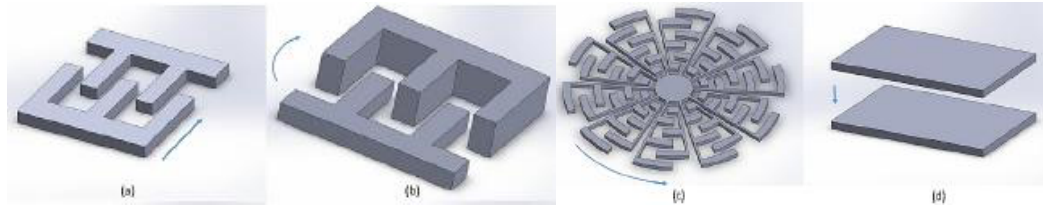
Figure 13. Schematic diagram of electrostatic actuators: ( a ) linear comb-drives; ( b ) vertical comb drives; ( c ) rotary comb drives; ( d ) parallel-plate actuators (taken with the permission of [93] ).